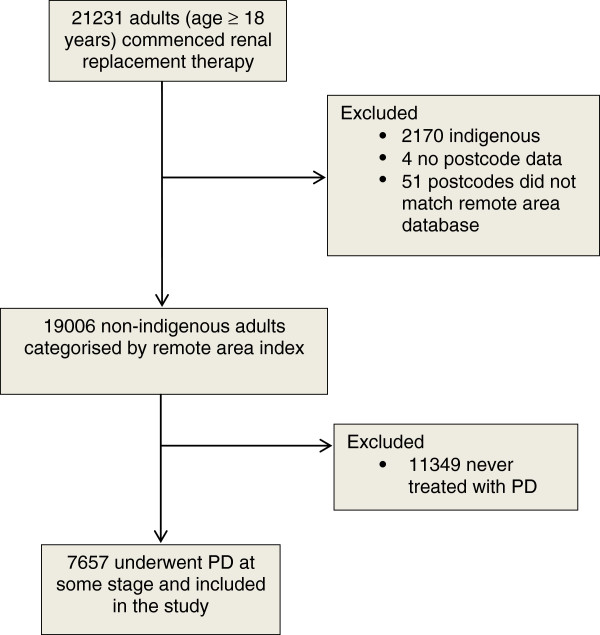
Flowchart of patients included in the study. PD = peritoneal dialysis.